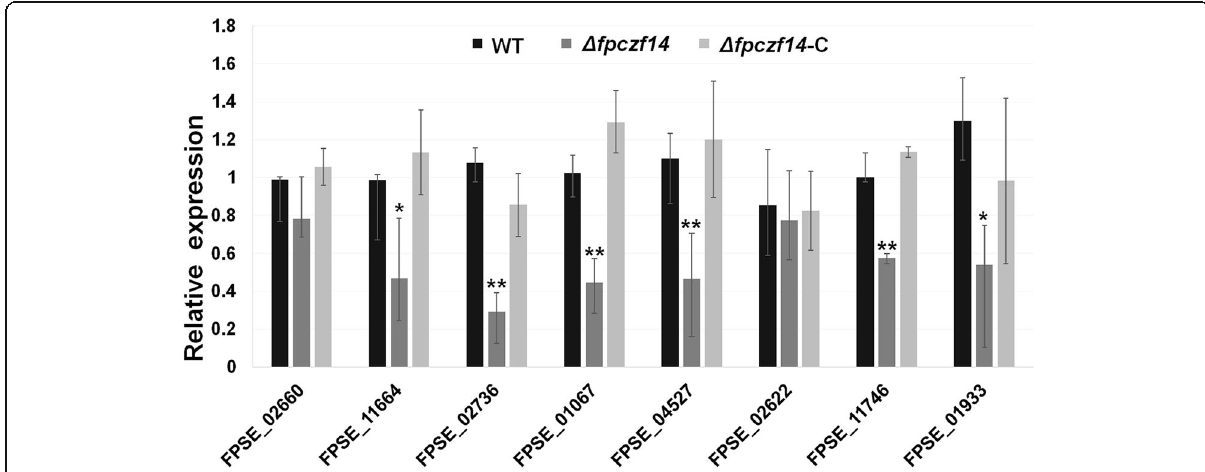
Fig. 6 RT-qPCR analyses of eight conidiation-related genes in WT, Δ fpczf14 and Δ fpczf14 -C ( t -test, * P < 0.05, * P <